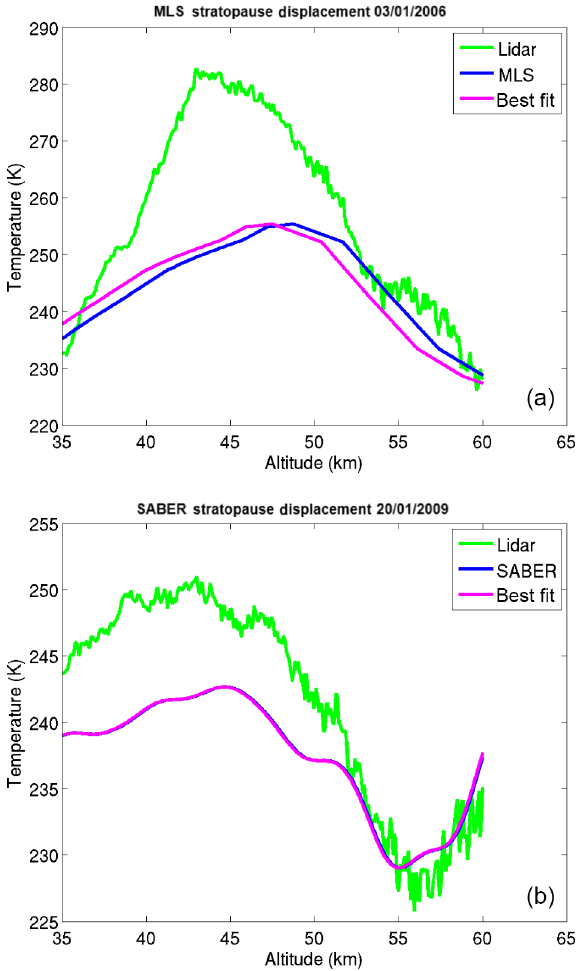
Figure 9. Two examples of poor matches between lidar and satel- lite temperature profiles (MLS, a ; SABER, b ). These mismatches mainly occur between late November and early April on nights dur- ing which the stratosphere was disturbed and experiencing a warm- ing.